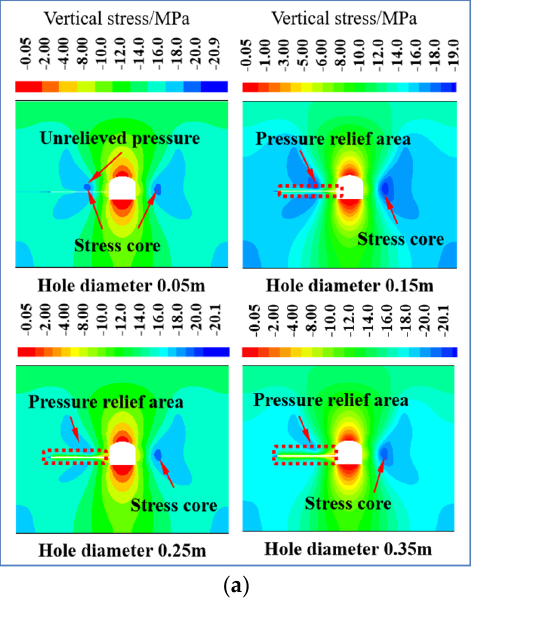
Figure 4. Pressure relief characteristics of the large − diameter borehole with different hole diameters. ( a ) Evolution characteristics of the stress contour plot with different hole diameters. ( b ) Evolution characteristics of the stress curves with different hole diameters.